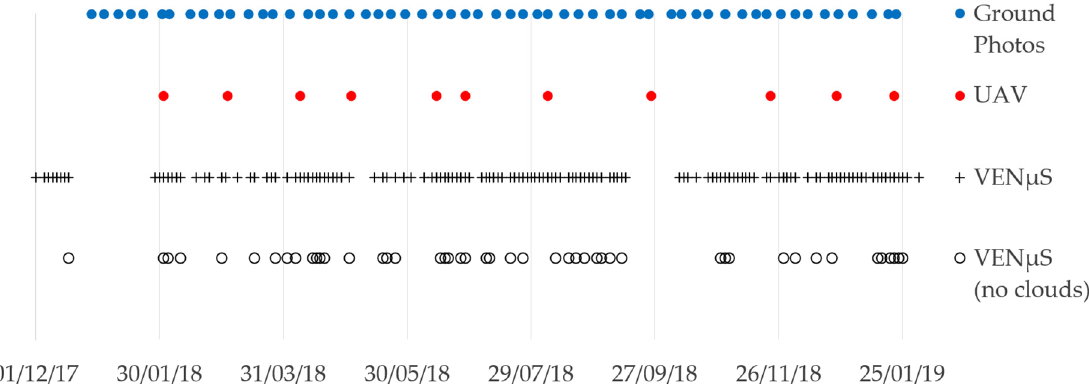
Figure 3. Data availability of ground photos, UAV and VEN μ S acquisitions in the research area, between December 2017 and January 2019.